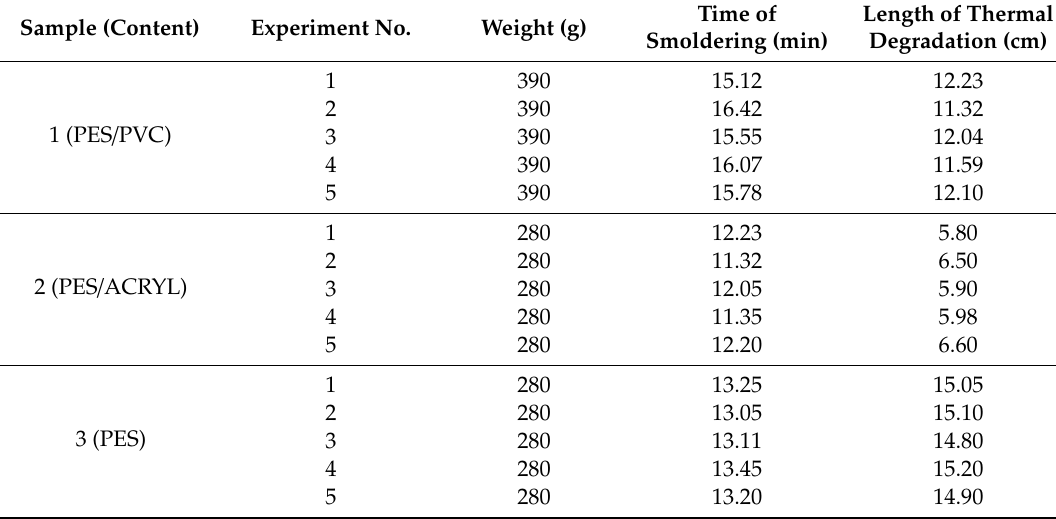
Table 5. Results of Experiments ( N =